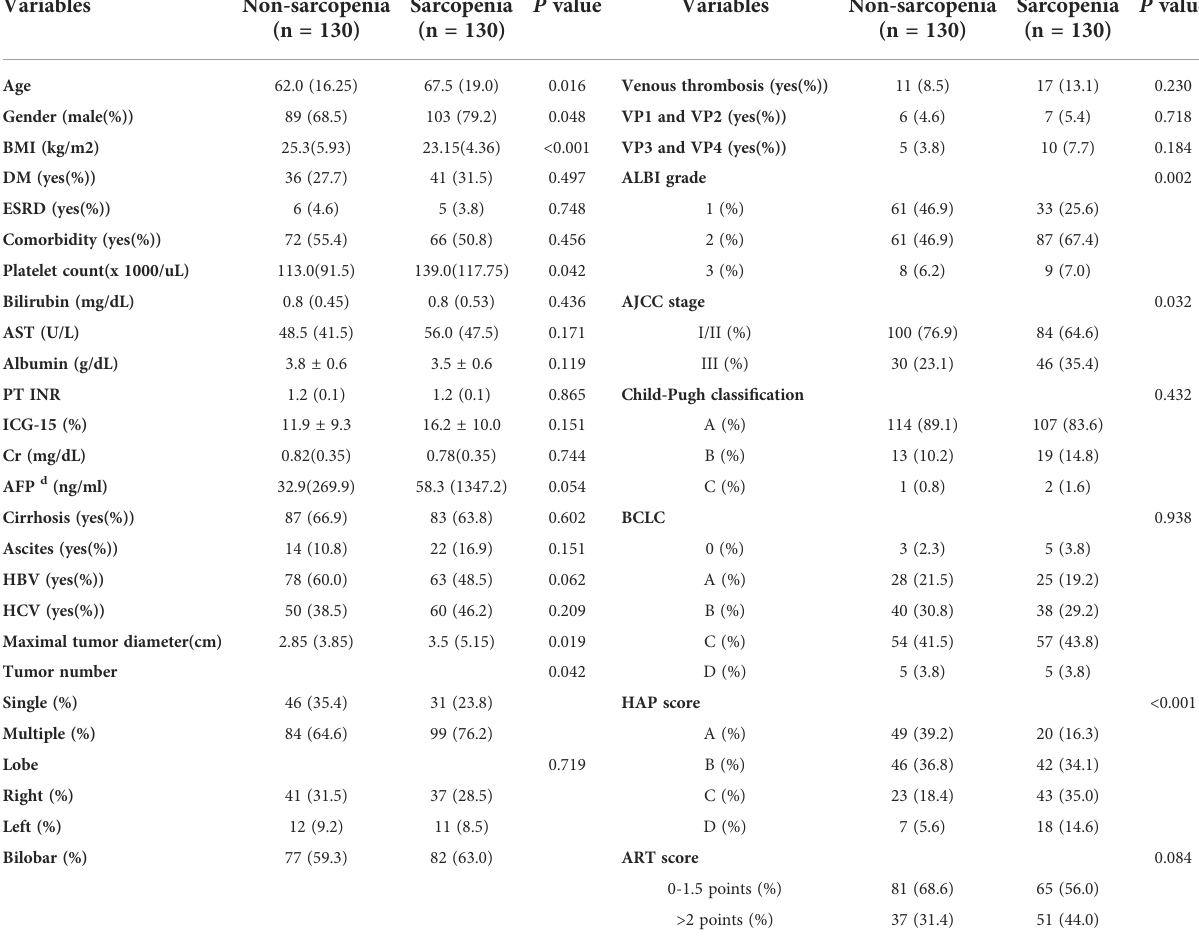
TABLE 2 Clinical characteristics of HCC patients with or without